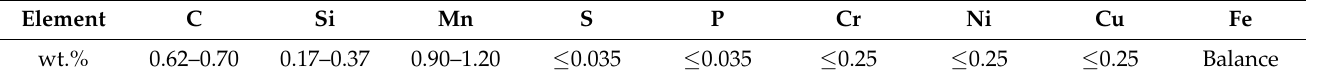
Table 1. Chemical composition of the received